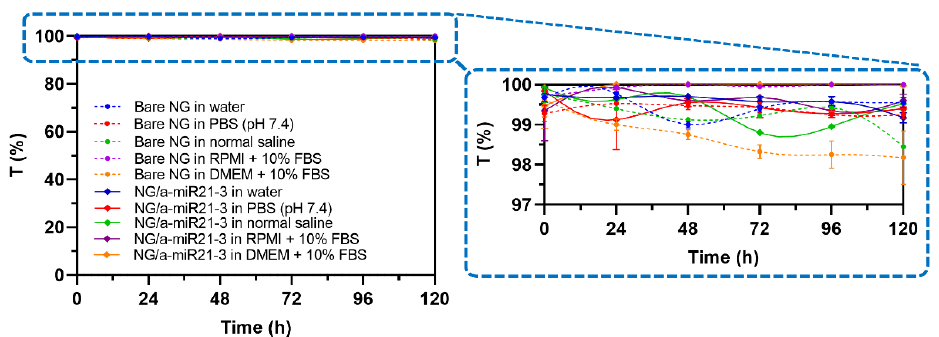
Figure 4. Transmittance values of bare NG and NG/a-miR21-3 dispersions for assessing their colloidal stability in different biological media at a working concentration of 100 µg/mL for 5 days at 37 °C. Data are reported as the mean ± SD (n = 4).